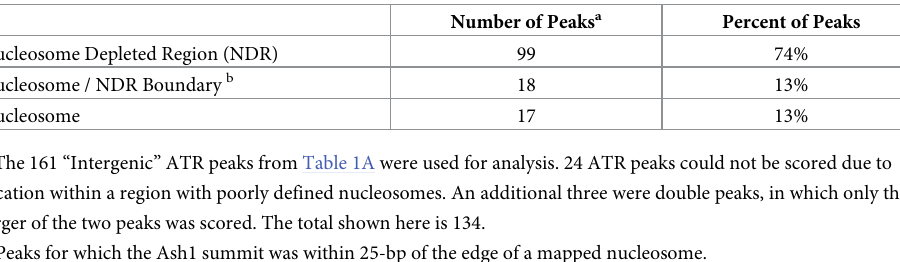
Table 3. Relationship of ATR Intergenic Peaks to Nucleosome